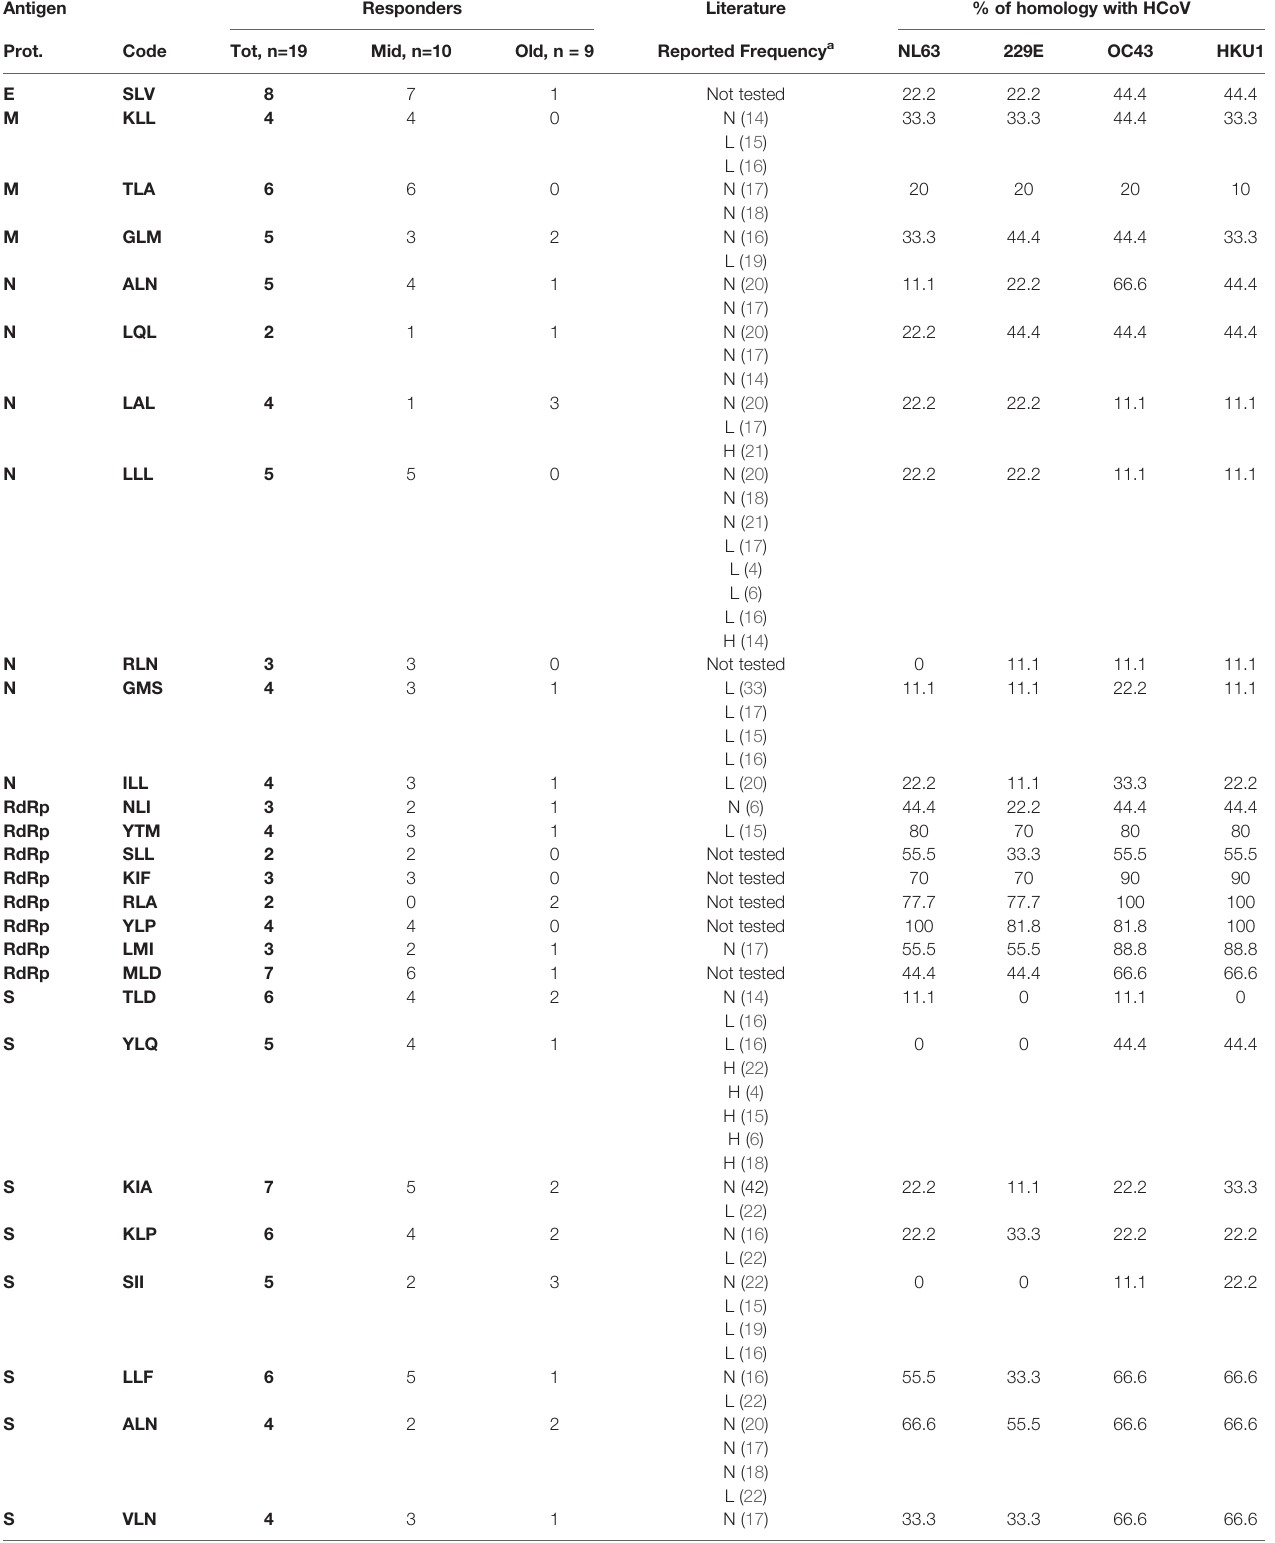
TABLE 1 | Responses to the HLA-A2-restricted, SARS-CoV-2-derived peptides used and homology with HCoVs. Antigen Responders Literature % of homology with HCoV